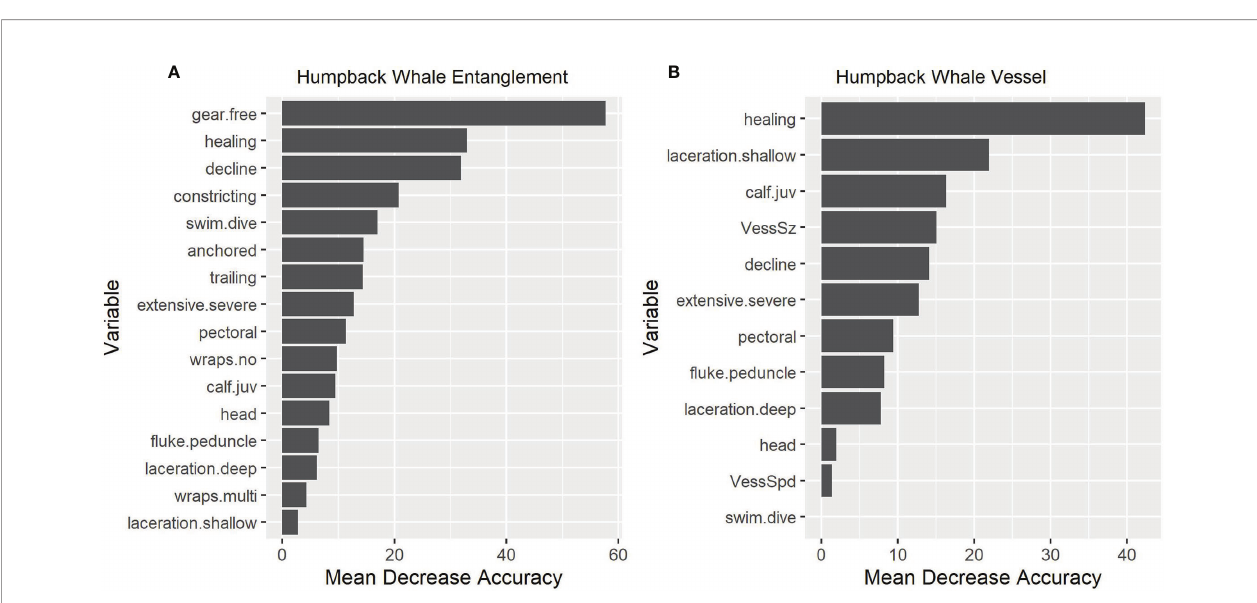
FIGURE 3 | Variable importance for entanglement (A) and vessel strike (B) models for humpback whales. The x-axis shows the mean decrease in classi fi cation accuracy (number of additional cases misclassi fi ed across all trees) when individual variables are